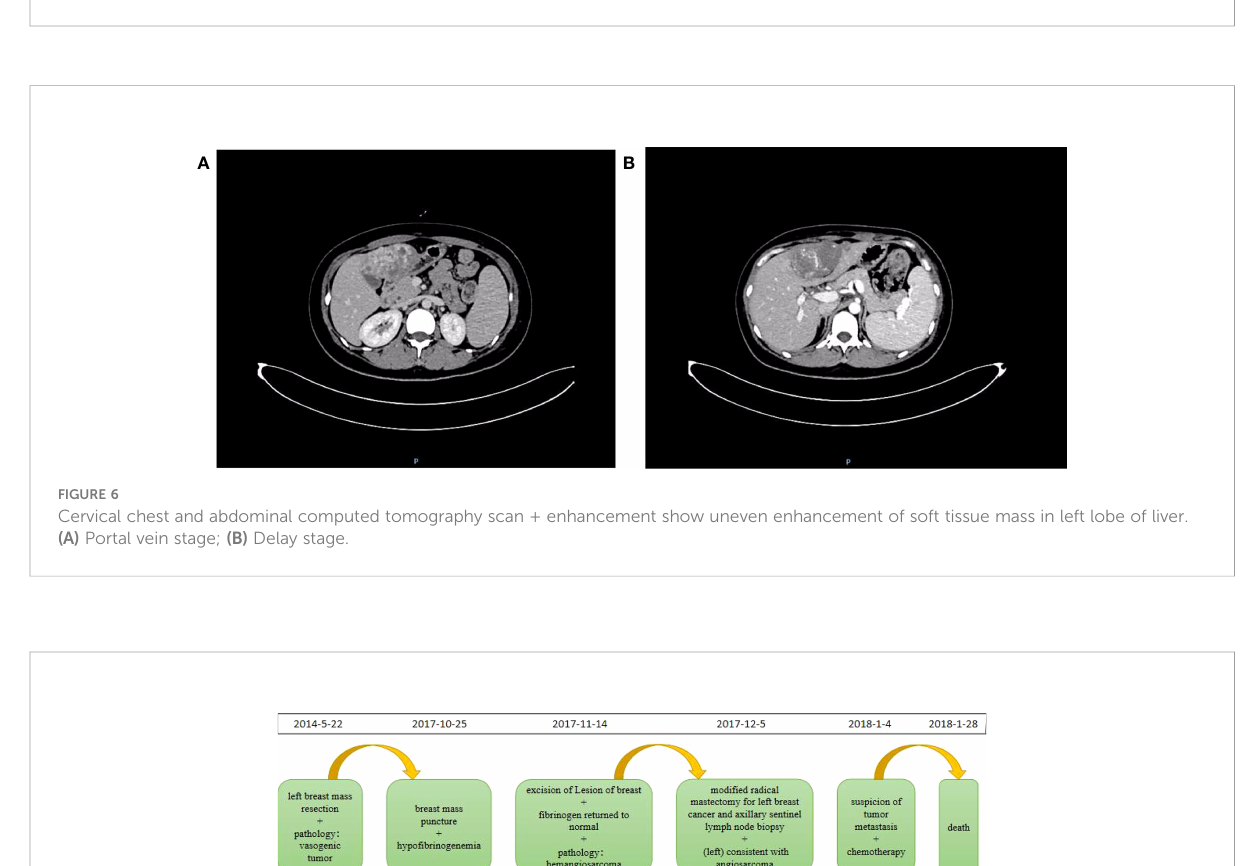
FIGURE 7 Timeline.